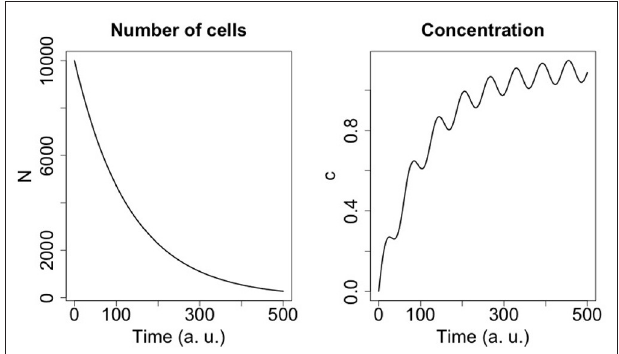
FIGURE 1 | Numerical simulation of the system defined by Equations (15) and (16) with E 0 = 0, E max = 100, k 1 = 0.005, k 2 = 0.0004, EC 50 = 15, h = 0.001, k = 1, A = 0.001, B = 0.001. As shown later, numerical simulations for times greater than 500 time units, shows that after the first 500 time units the oscillatory behavior disappears to give way to a plateau.